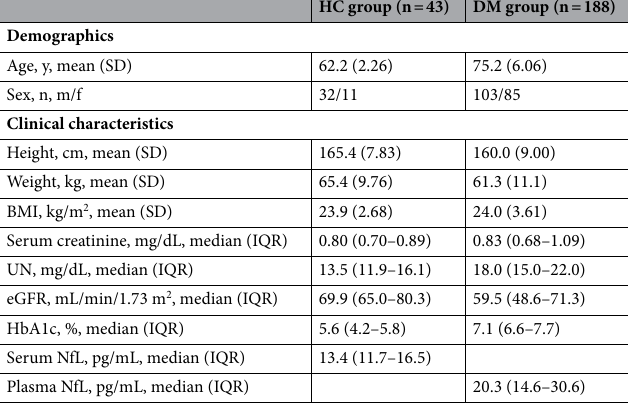
Table 1. Demographic data of the two groups examined in this study. SD standard deviation; IQR interquartile range; BMI body mass index; UN urea nitrogen; eGFR estimated glomerular filtration rate; NfL neurofilament light chain; HbA1c hemoglobin A1c.